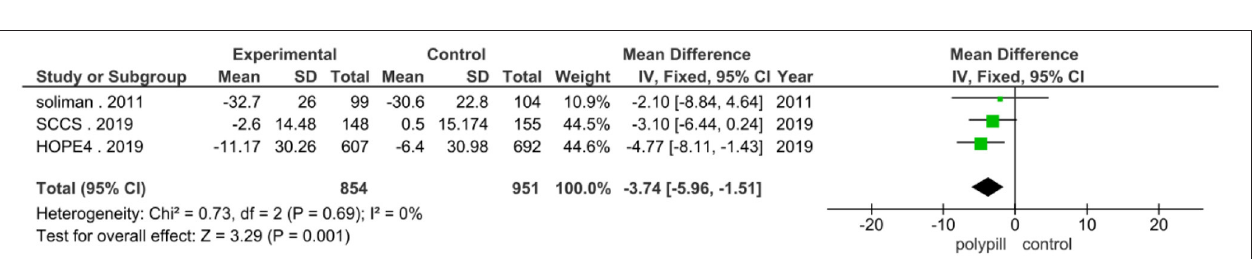
FIGURE 5 | Forest plot according to risk stratification: intermediate and high-risk patients subgroup analysis.